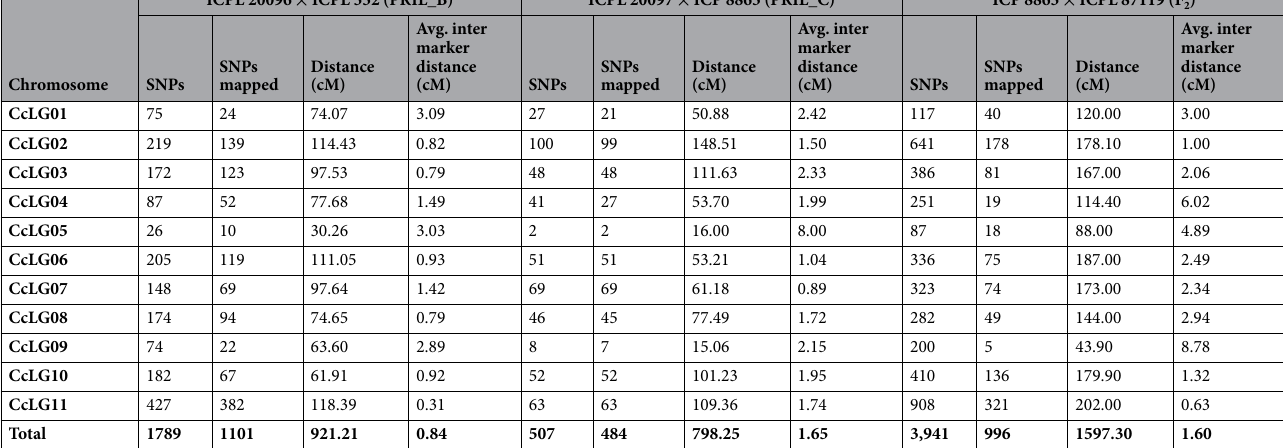
Table 1. Features of genetic maps in ICPL 20096 × ICPL 332 (PRIL_B), ICPL 20097 × ICP 8863 (PRIL_C) and